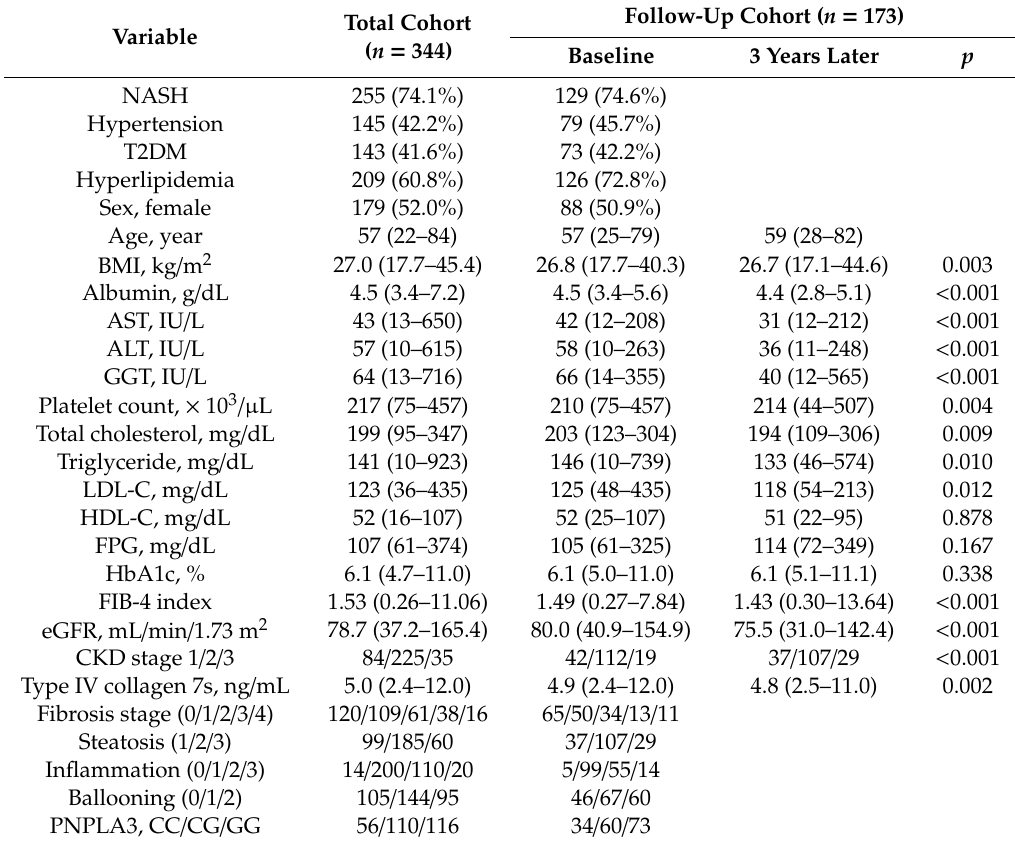
Table 1. Characteristics of the total and follow-up patient cohorts with non-alcoholic fatty liver disease. Variable